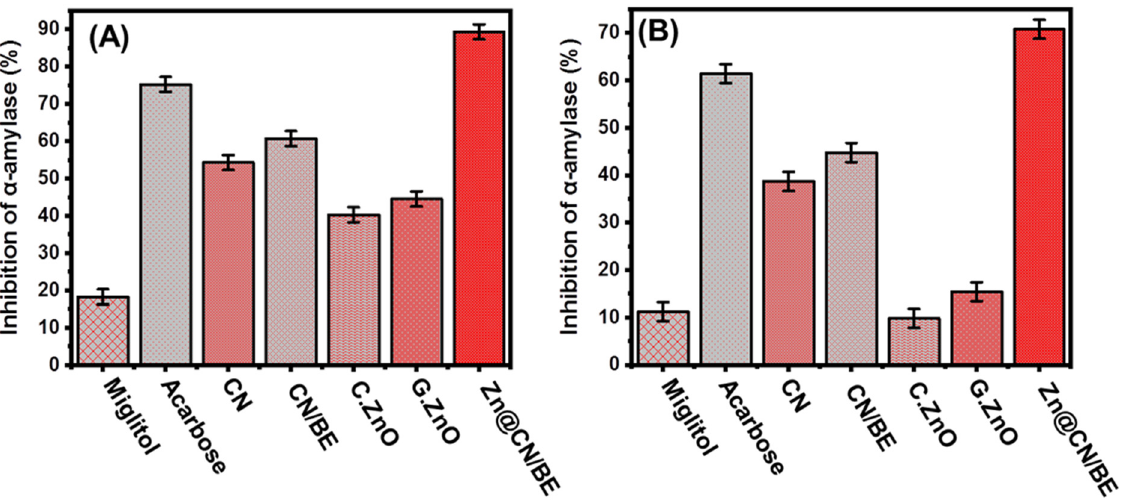
Figure 5. The α -amylase inhibition activities of CN, CN/BE, commercial ZnO, green ZnO, and Zn@CN/BE structures (500 μ L; 100 μ g/mL) (the tests were replicated 5 times) ; ( A ) Porcine pancreatic α -amylase enzyme (100 μ L; 50 μ g/mL); and ( B ) Murine pancreatic α -amylase enzyme (100 μ L; 50 μ g/mL).